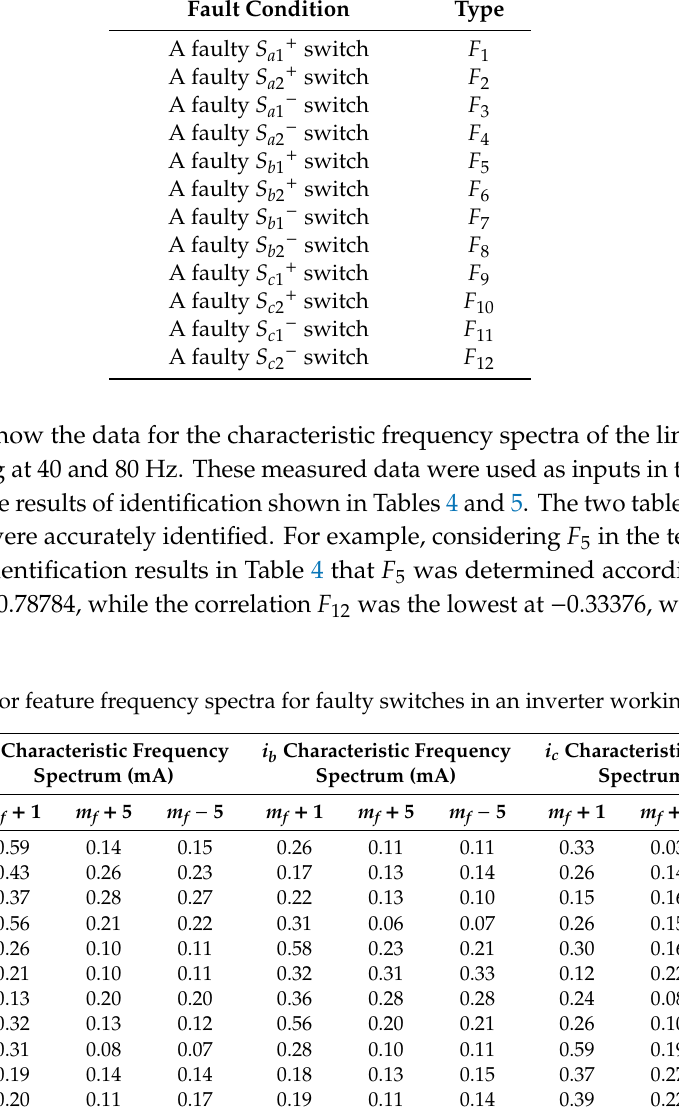
Table 3. Data for feature frequency spectra for faulty switches in an inverter working at 80 Hz.